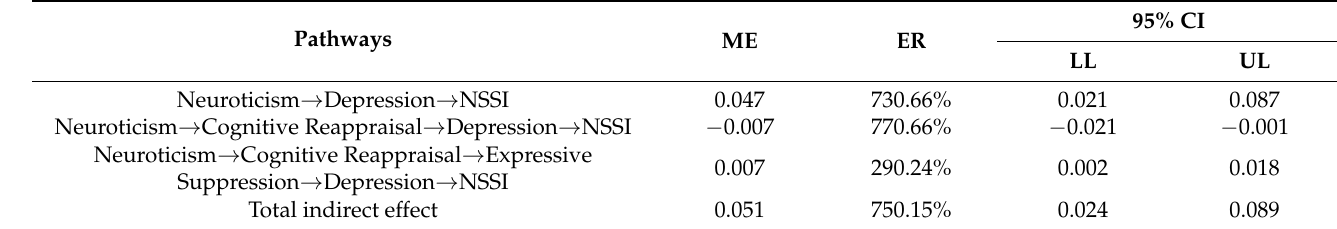
Table 7. Mediation effect analysis of neuroticism, emotion regulation, depression, and NSSI among female college students.